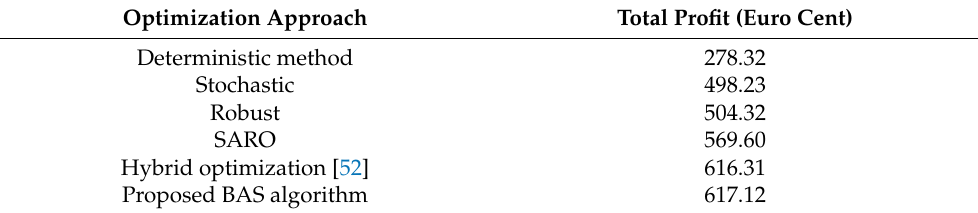
Table 11. Comparison of optimization